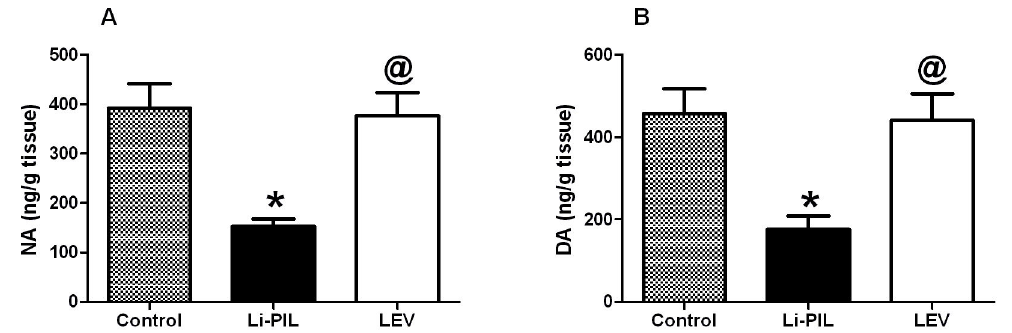
Figure 1. Effect of levetiracetam (LEV, 500 mg/kg i.p.) on hippocampal noradrenaline (NA; A) and dopamine (DA; B) in lithium-pilocarpine (Li-PIL)-induced convulsion in rats. Values are means ± S.E.M. of 6 rats as compared to control (*) and Li- PIL ( @ ) groups. Comparisons were carried out using one-way ANOVA followed by Student–Newman–Keuls Multiple Comparisons Test, P